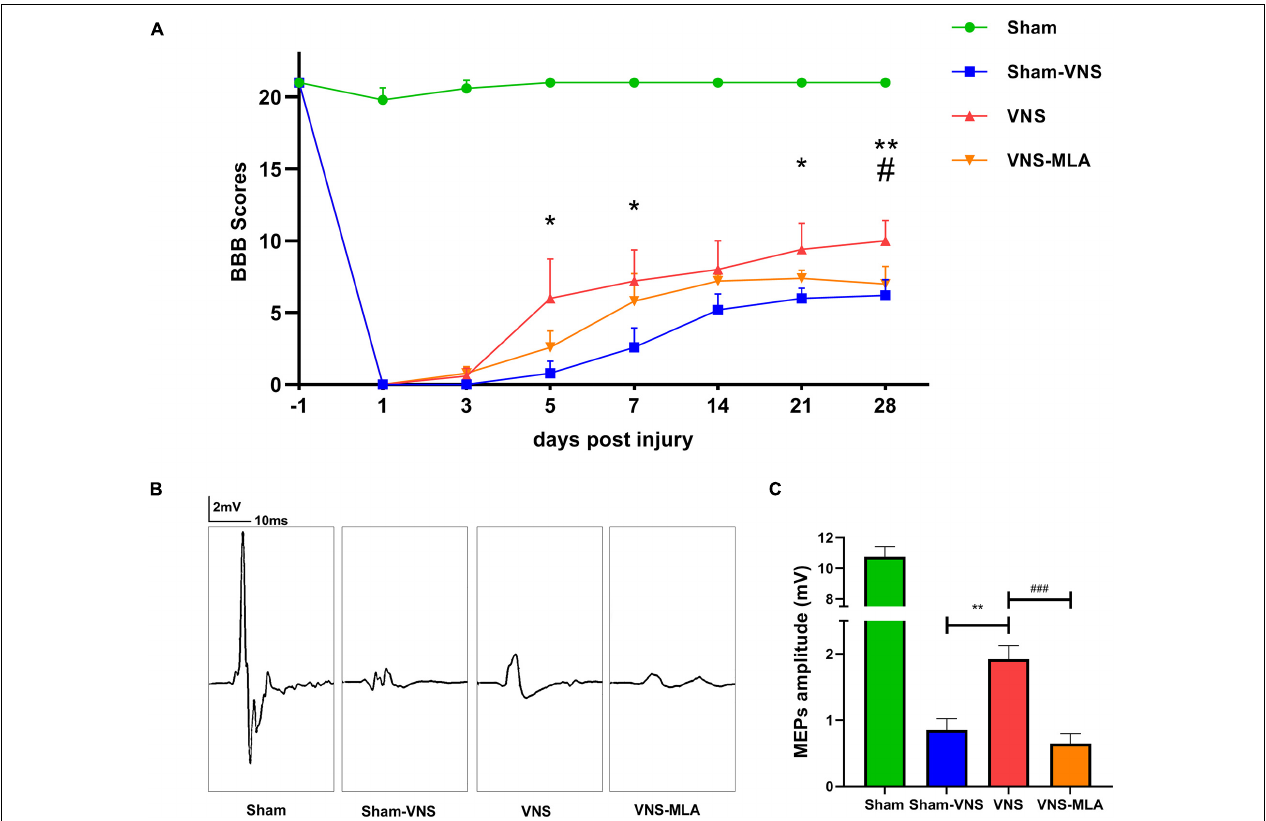
FIGURE 1 | Vagus nerve stimulation (VNS) promoted functional behavioral recovery after spinal cord injury (SCI). (A) Basso-Beattie-Bresnahan (BBB) was used to functionally grade the rats in the Sham, Sham-VNS, VNS, and VNS-MLA groups up to 28 days post-injury, n = 5 per group. (B,C) Representative recordings and analysis of motor evoked potentials (MEPs) in different groups at day 28 post-injury, n = 5 per group, scale: 2 mV/10 ms. * P < 0.05, ** P < 0.01 between the Sham and Sham-VNS groups, # P < 0.05, ## P < 0.01 between the VNS and VNS-MLA groups.